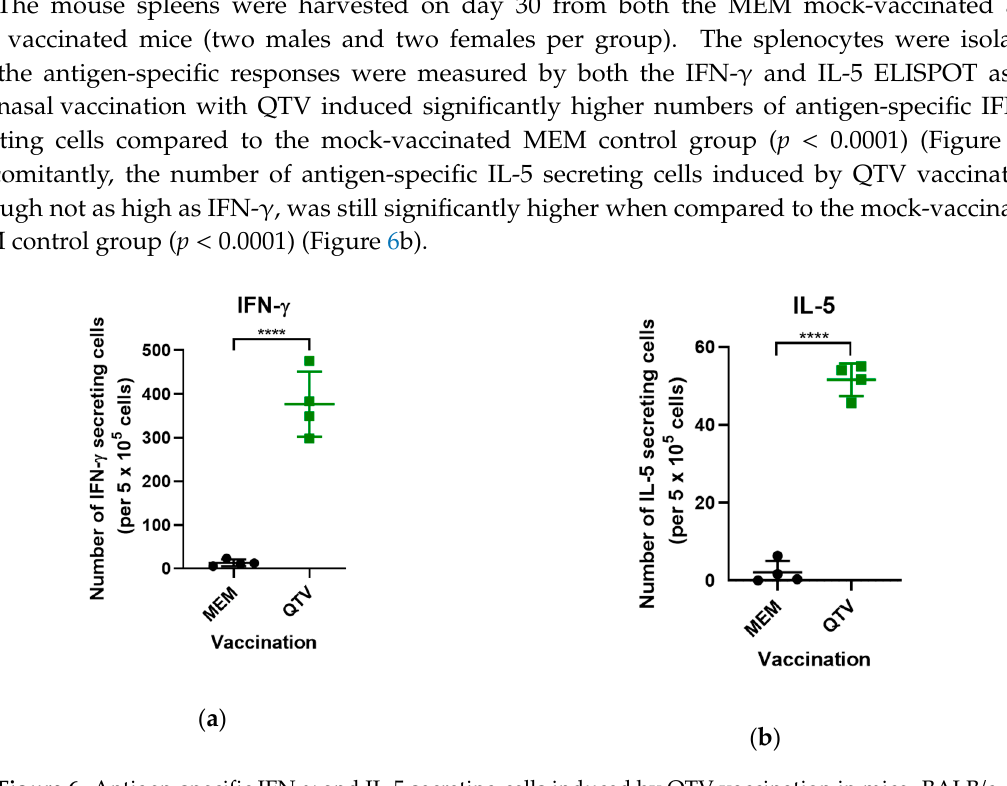
Figure 6. Antigen-specific IFN- γ and IL-5 secreting cells induced by QTV vaccination in mice. BALB / c mice were vaccinated with two doses of MEM (control) or QTV virus (1 × 10 3 PFU). Nine days after the second vaccination (day 30), BALB / c mice (four mice per group, two males and two females) were euthanized and their splenocytes were isolated. The numbers of IFN- γ ( a ) and IL-5 ( b ) secreting T cells per 5 × 10 5 splenocytes were determined by ELISPOT. Each sample was tested in triplicate. The antigen-induced counts were determined by subtracting the number of IFN- γ or IL-5 secreting cells with the medium-treated control cells. The data is shown as the mean ± the standard deviation. The dots correspond to the values obtained from individual mouse samples. Significant di ff erences among groups are signified by **** ( p < 0.0001). ns = not significant. A one-way ANOVA was performed, which was followed by the Tukey post-hoc test to determine the P-value.